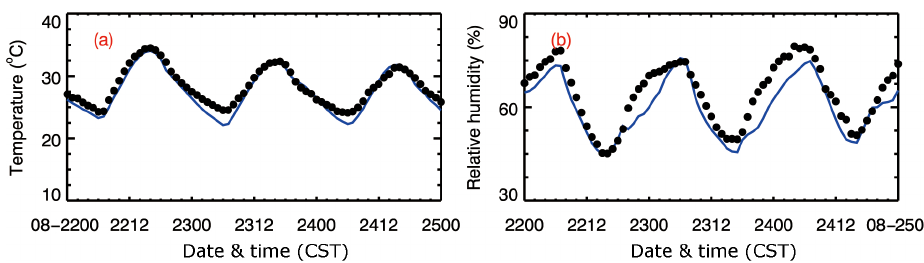
Figure 5. Observed (black dots) and simulated (blue lines) diurnal profiles of (a) surface temperature and (b) relative humidity averaged over six meteorological sites from 22 to 24 August 2013.